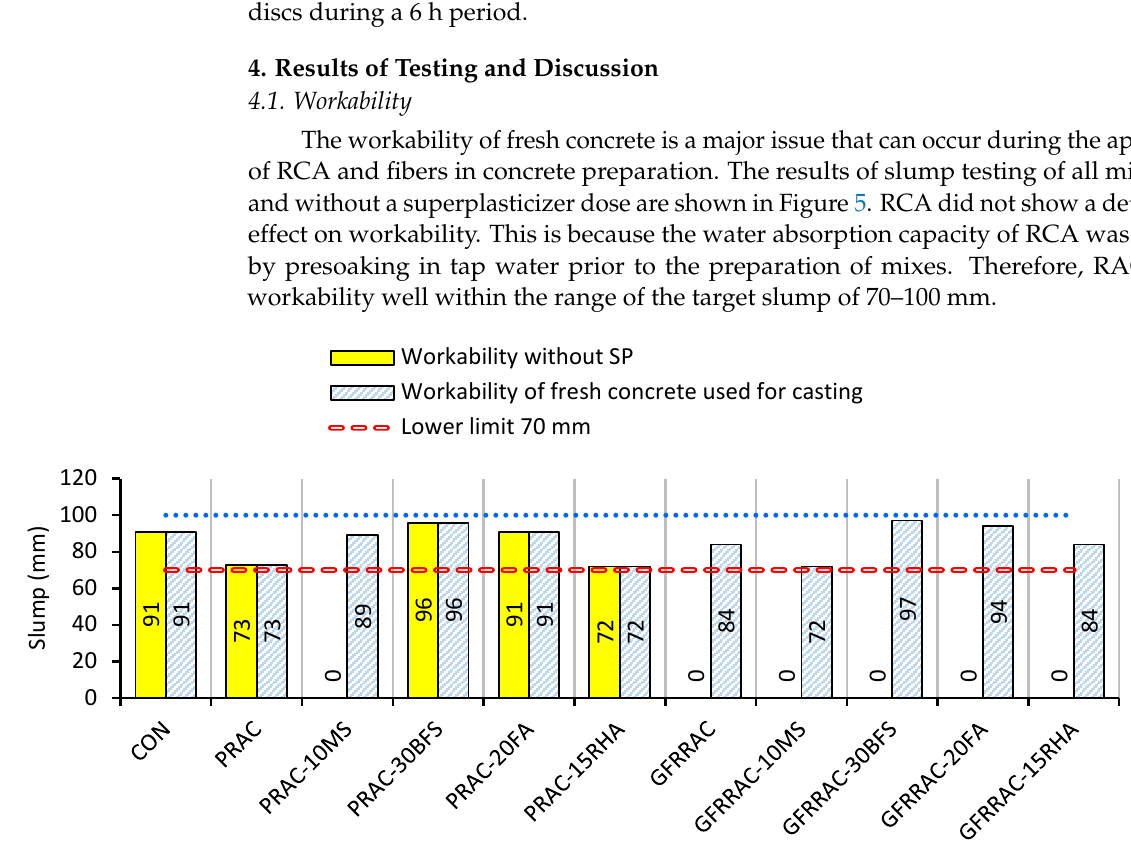
Figure 5. Workability test results of RAC with glass fibers and mineral admixtures.